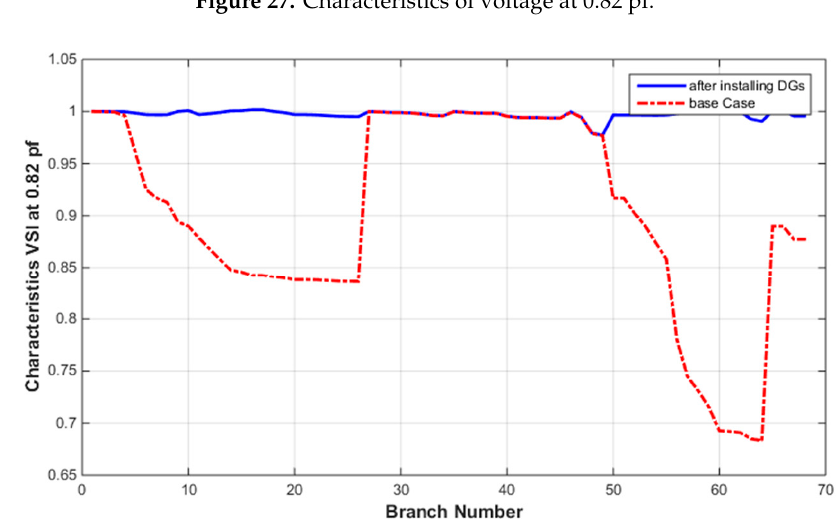
Figure 28. Characteristics of VSI at 0.82 pf.